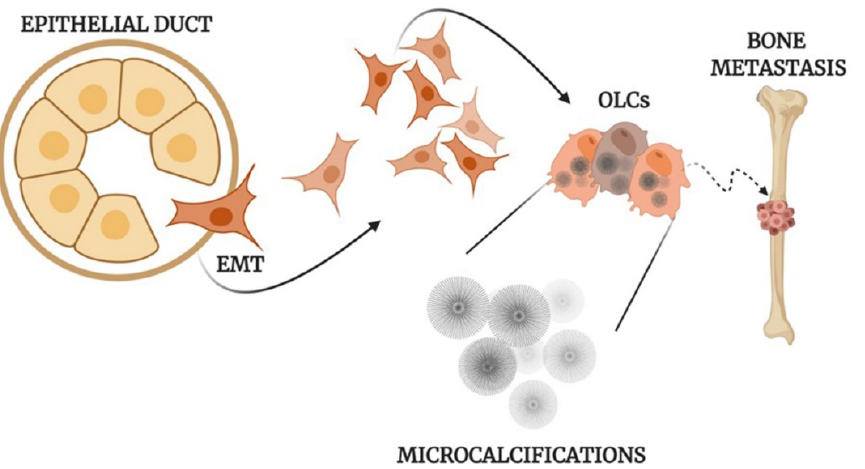
Figure 1. Mechanisms of the formation of calcifications. Schematic representation of osteoblast differentiation, microcalcification production, and metastasis development in human epithelial tumors. * EMT: Epithelial to mesenchymal transition; OLCs: Osteoblast-Like Cells ** created with BioRennder.com